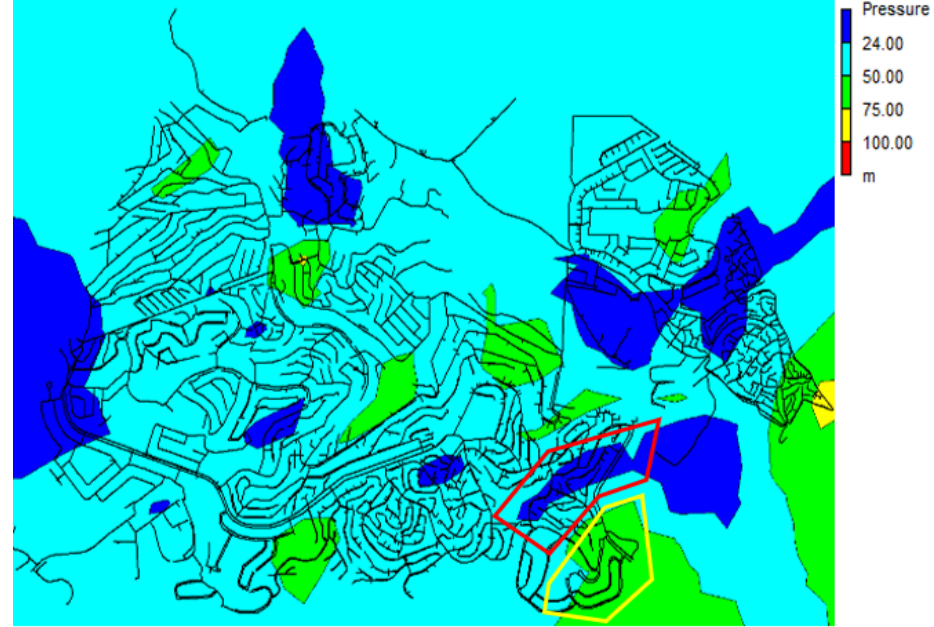
Figure 8. Pressure head reduction due to PAT-1, PAT-2, PAT-4 and PAT-5 installed in the WDN. (Changes outlined in